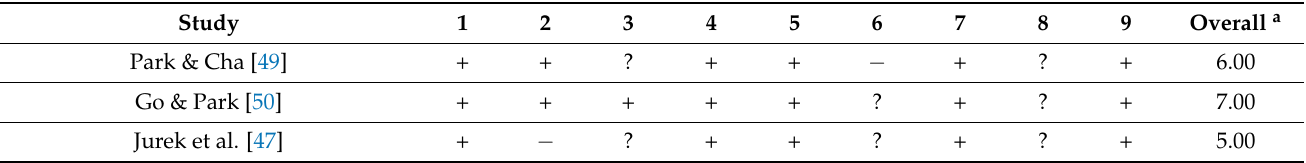
Table 5. Results of JBI Critical Appraisal for Quasi-Experimental Studies.